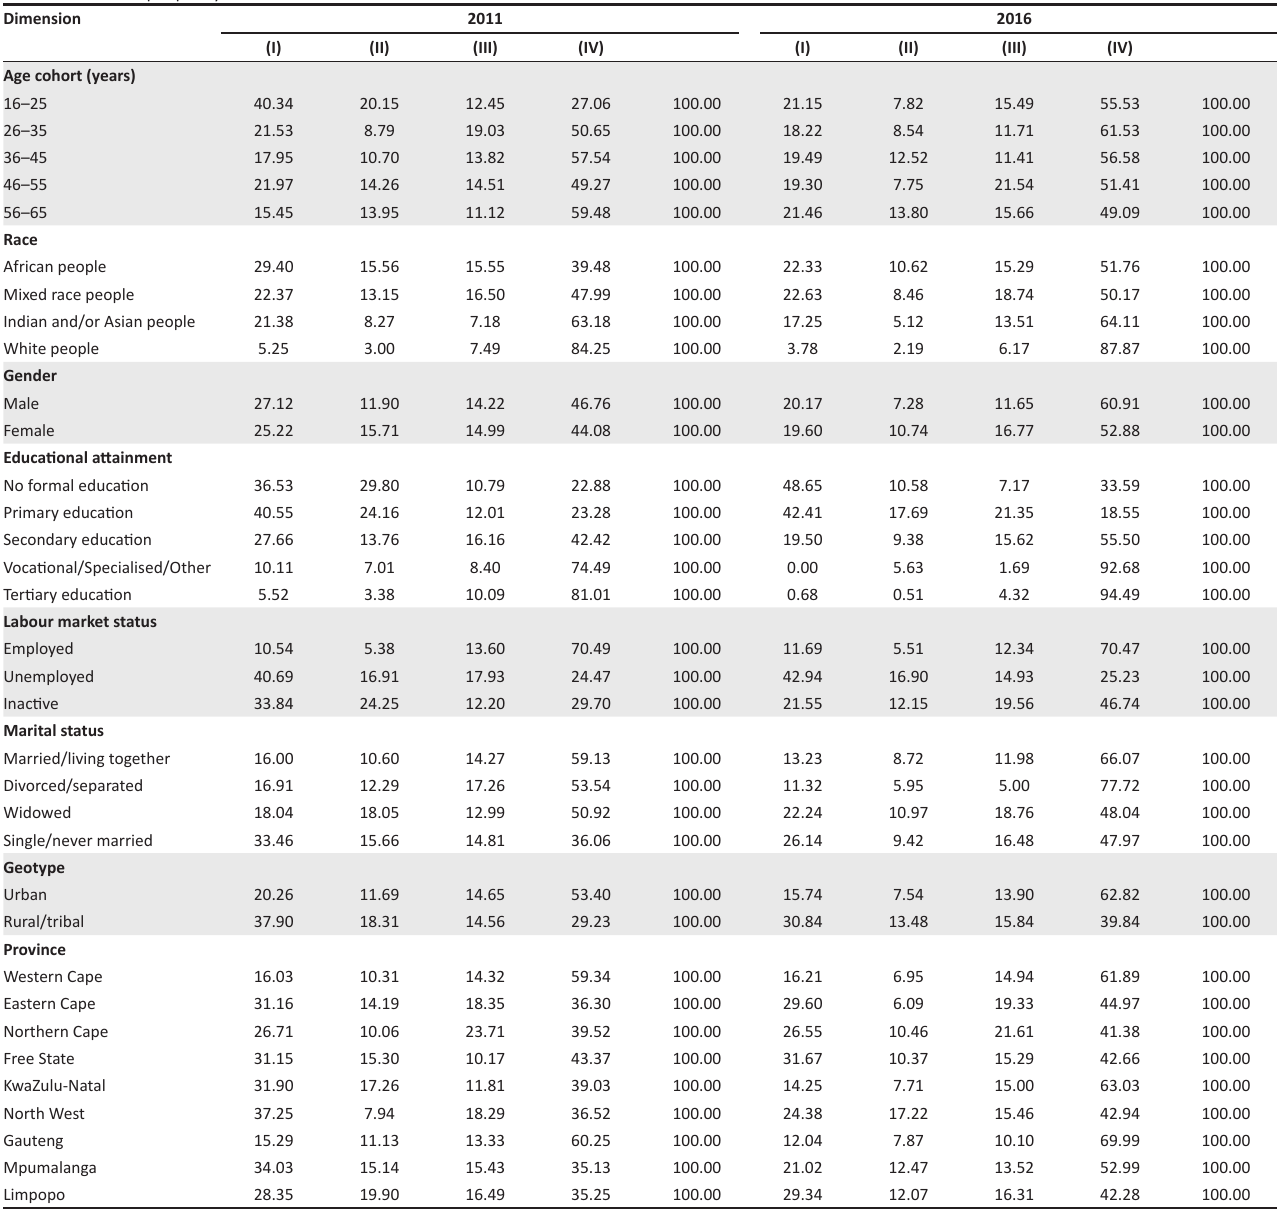
TABLE 5: Profile of people by financial inclusion and financial health statuses.